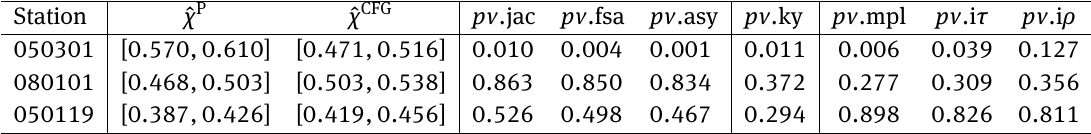
Table 3: Couple ( Q , V ) . Estimators based on the Pickands dependence function ˆ χ P and ˆ χ CFG . The p-values of the bivariate tests of extreme-value dependence based on (i) Kendall’s process ( pv . jac, pv . fsa, pv . asy), (ii) the Pickands dependence